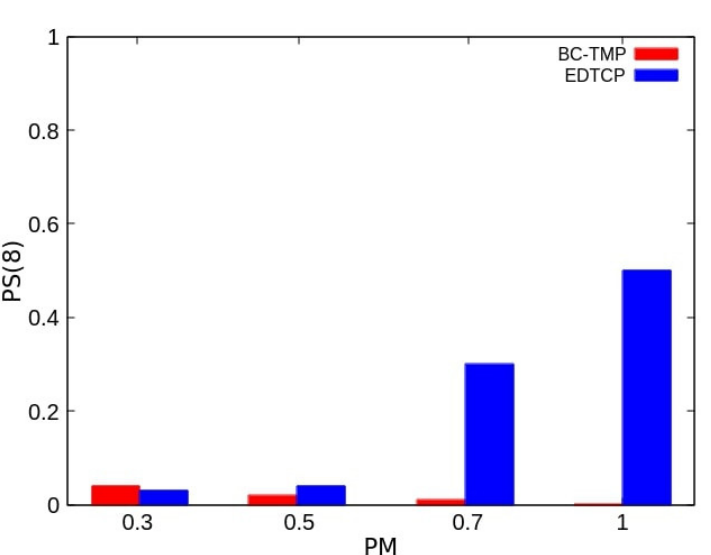
Figure 11. The fraction of malicious vehicles that reach trust metric greater than or equal to 0.8 vs. PM .